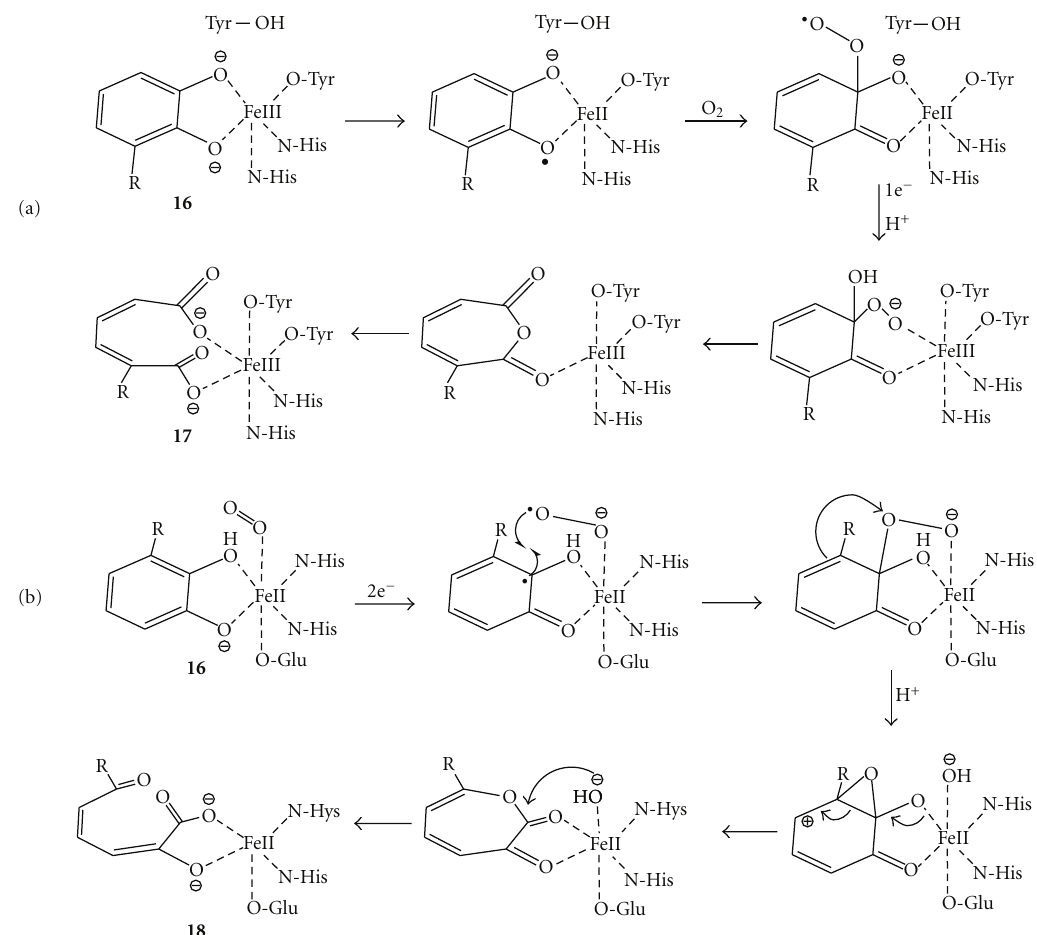
Scheme 7: The mechanisms of the C = C double bond cleavage of catechols catalysed by (a) intradiol dioxygenase and (b) extradiol